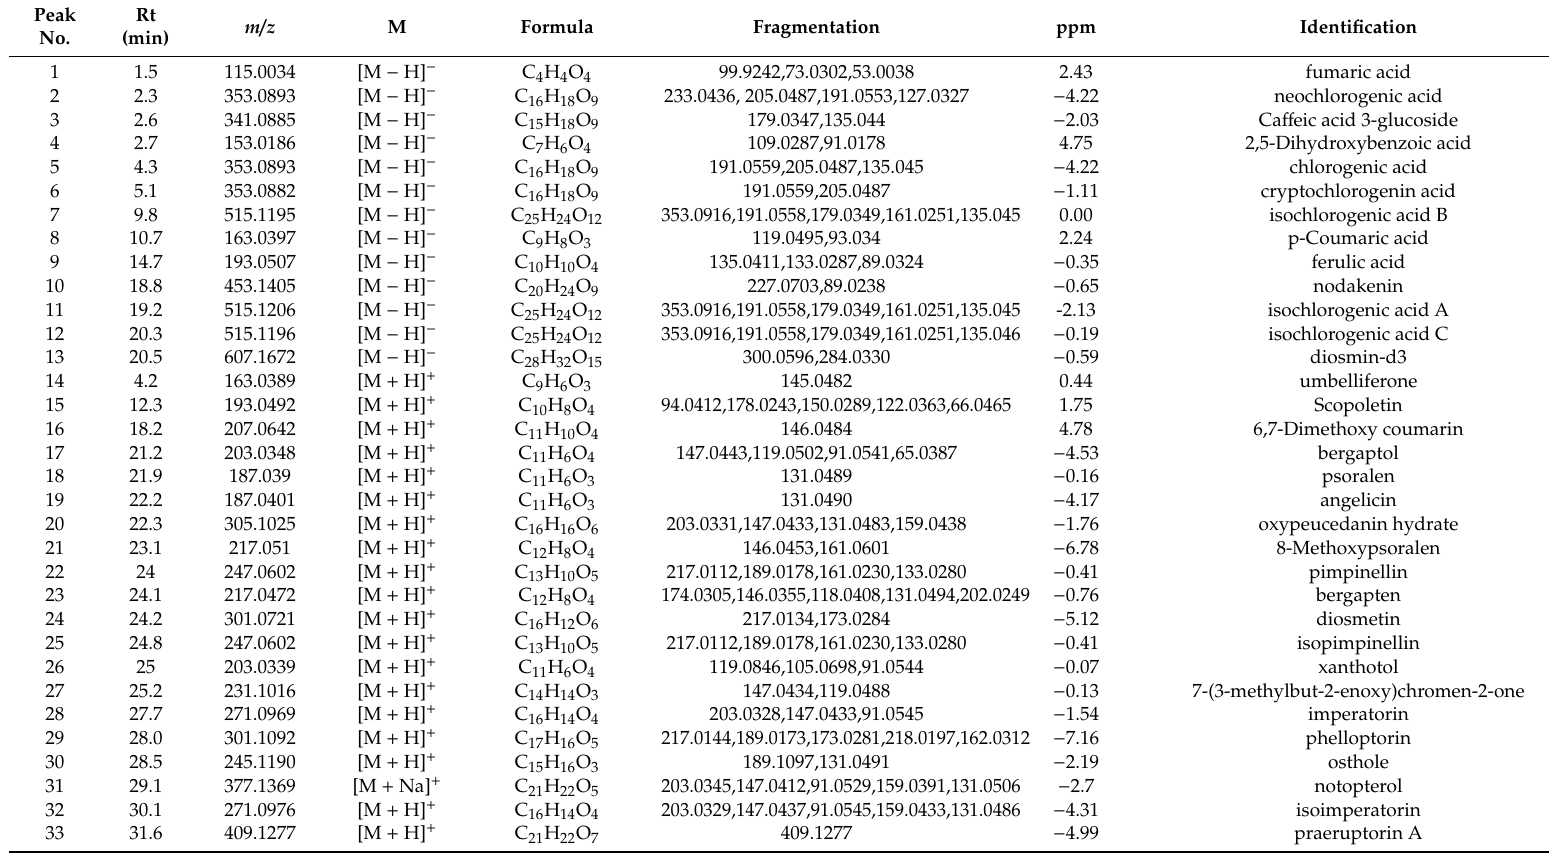
Table 5. UHPLC–Q–TOF data and identification of constituents from Notopterygii rhizoma and